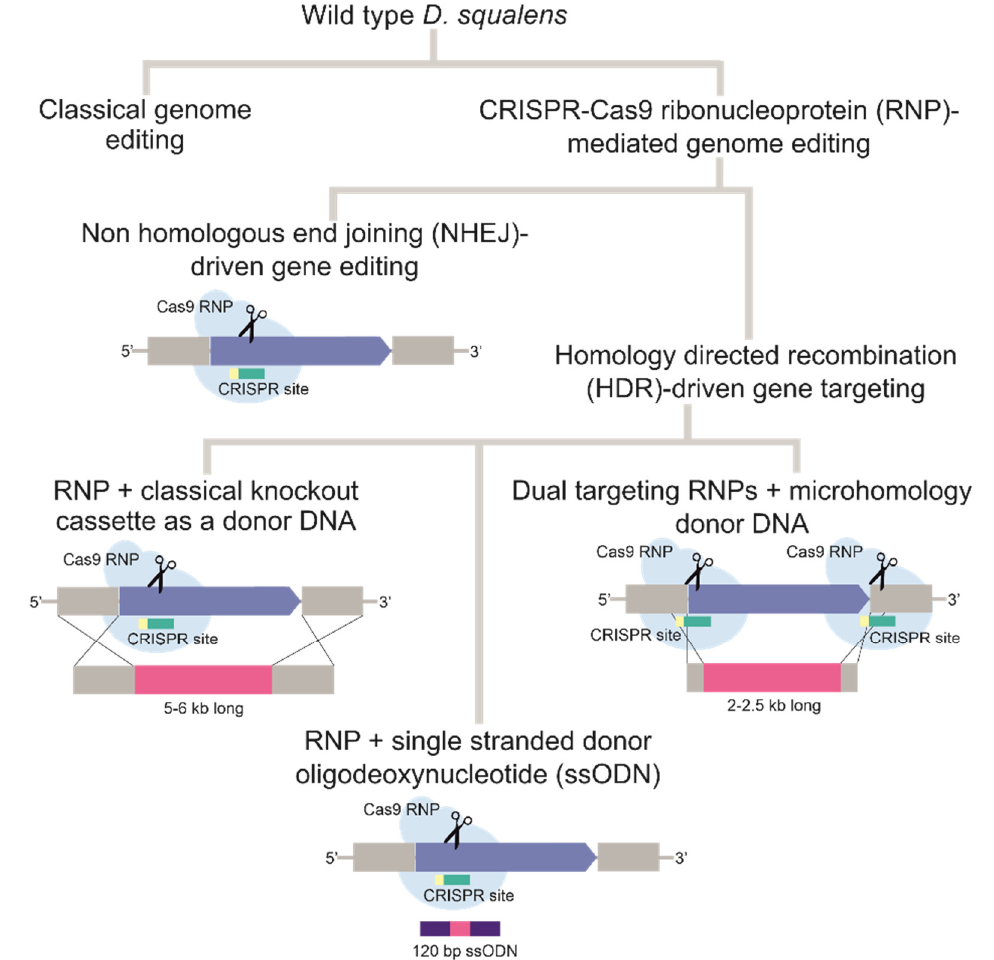
Figure 1. Flow diagram of the different approaches in the wild-type D. squalens strain.